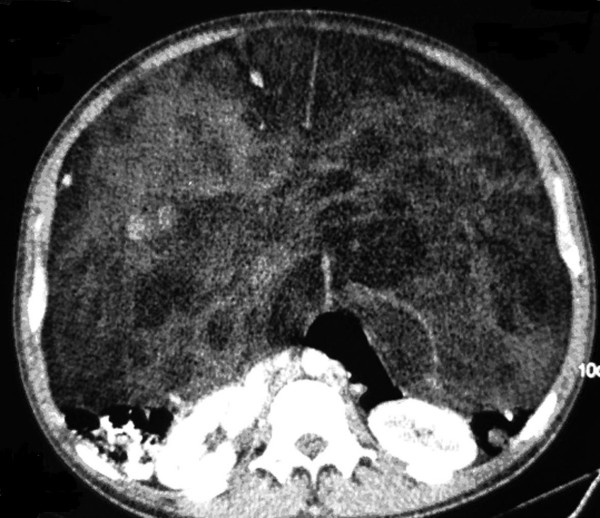
CT scan. Heterogeneous lesion is observed with zones of fat and solid density that entirely occupy the abdominal cavity, displacing retroperitoneal structures dorsally.